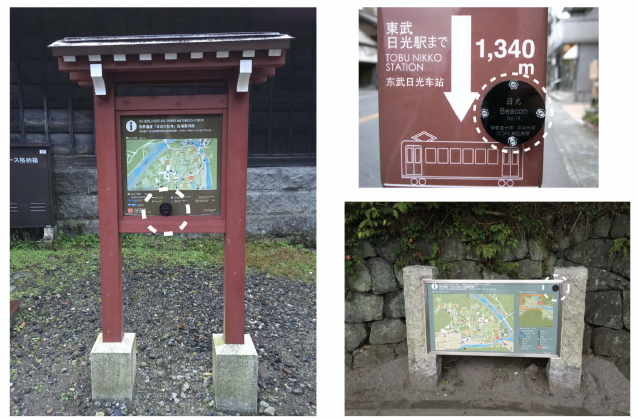
Figure 4. BLE beacons on the street in Nikko (in a white dotted circle).